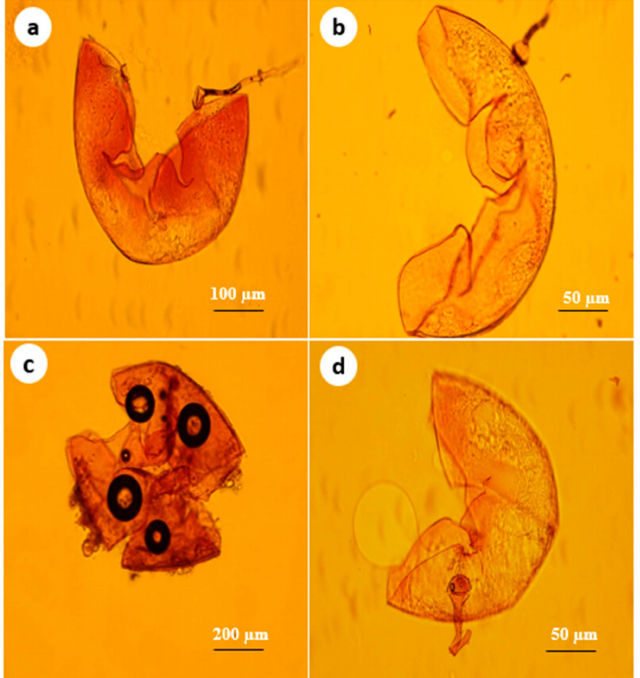
Figure 1. Arbuscular mycorrhizal fungi spores collected from the trap culture: crushed spore spores of Gigaspora albida ( a , b ); crushed spores of Gigaspora margarita ( c , d